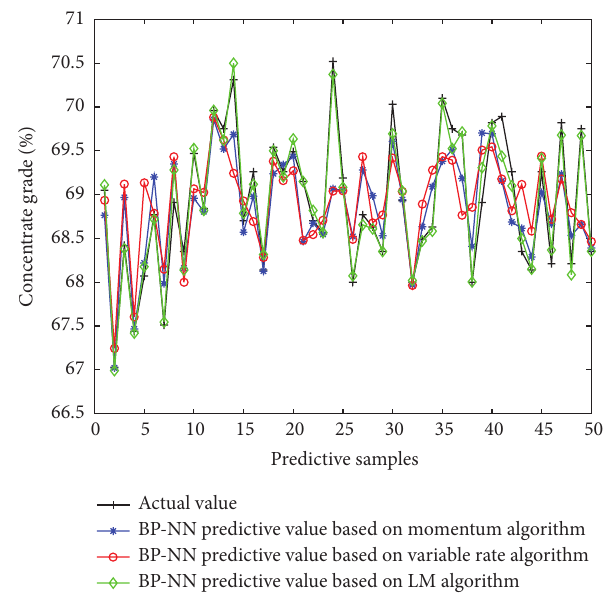
Figure 10: Predictive results of soft-sensor